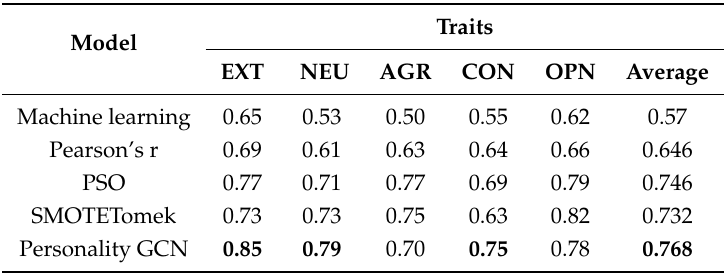
Table 5. Personality GCN classification results of F1-score on the myPersonality dataset. Model